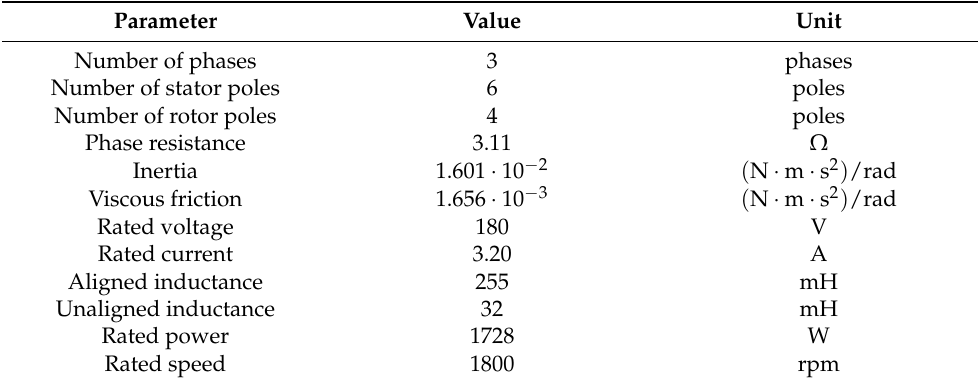
Table 1. Parameters of the SRG used in this study.